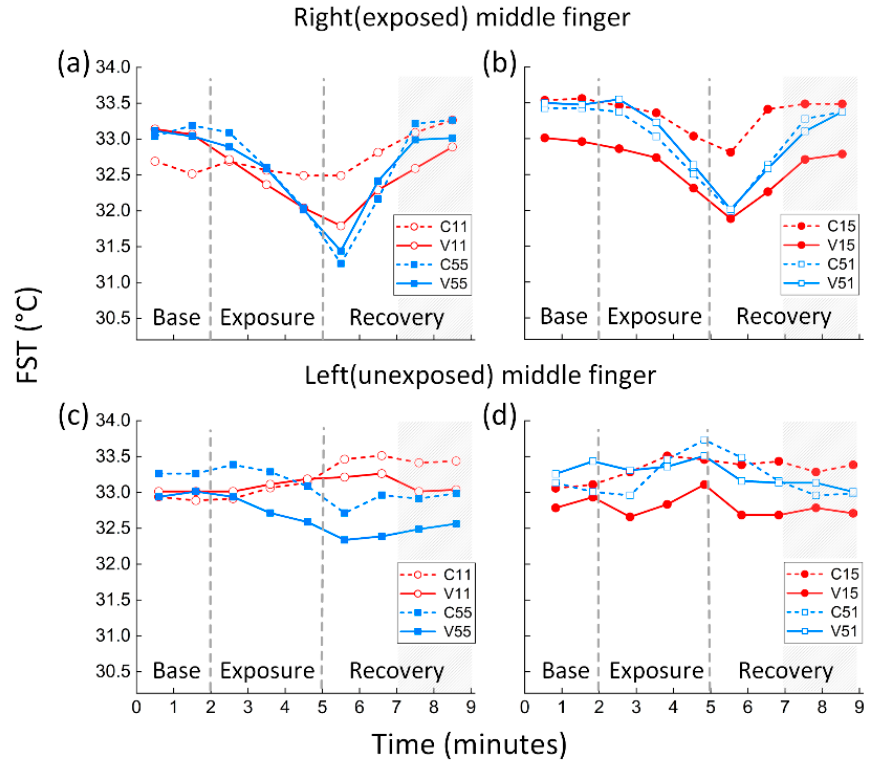
Figure 4. Absolute change of finger skin temperature in the ( a , b ) right (exposed) fingers and ( c , d ) left (unexposed) fingers at every minute during the eight exposure conditions (see Table 1). The resting period of each following round was considered as the latter part of the recovery period of the previous round. Plotted symbols are median values of FST.